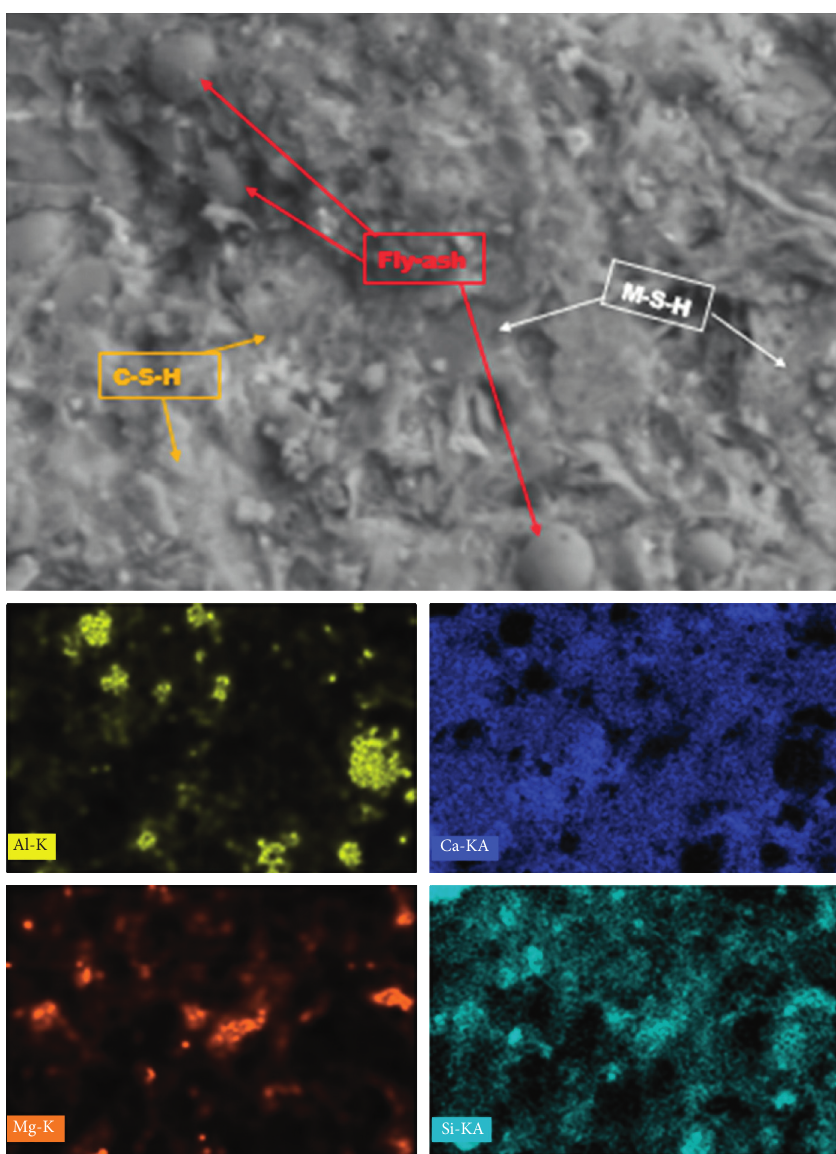
Figure 16: SEM image and corresponding EDX mapping for Al, Ca, Mg, and Si in